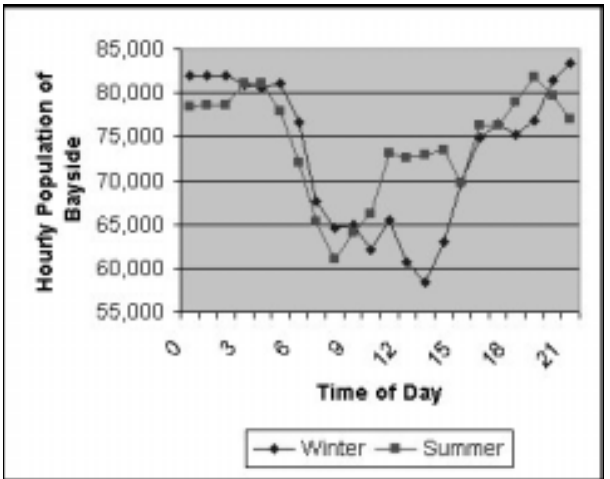
Figure 7. Seasonal variation in hourly population of